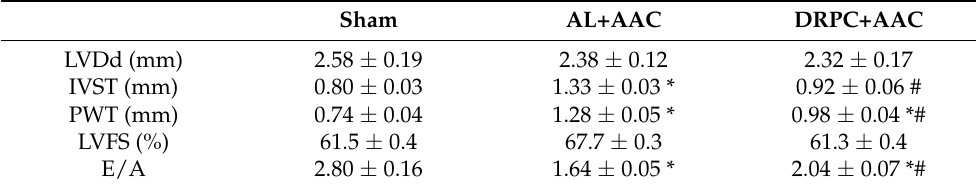
Table 1. Echocardiographic data 2 weeks after surgery.